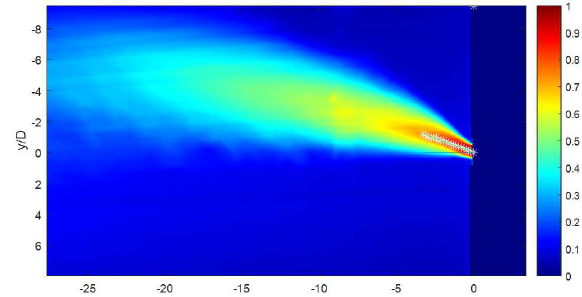
Fig. 6. Mean non-dimensional concentration C/C 0 field ( C 0 is the mean concentration measured at the outlet, i.e. the initial jet concentration) for a jet with r = 0.015 ( θ ≈ 27°); the white asterisks are the concentration maxima in the initial region of the jet, the green line is the jet axis, the blue line is the line perpendicular to the pipe